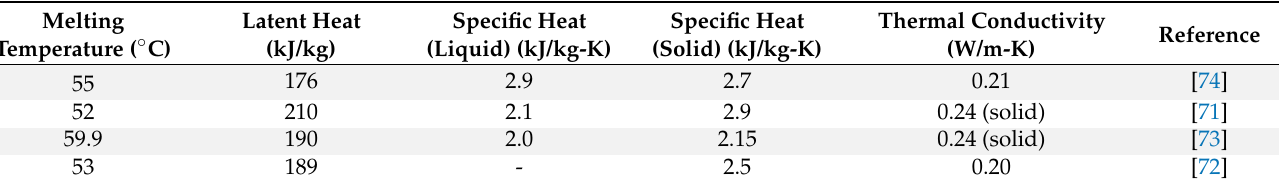
Table 5. Comparison of thermal properties of paraffin wax found in the literature [72–75].